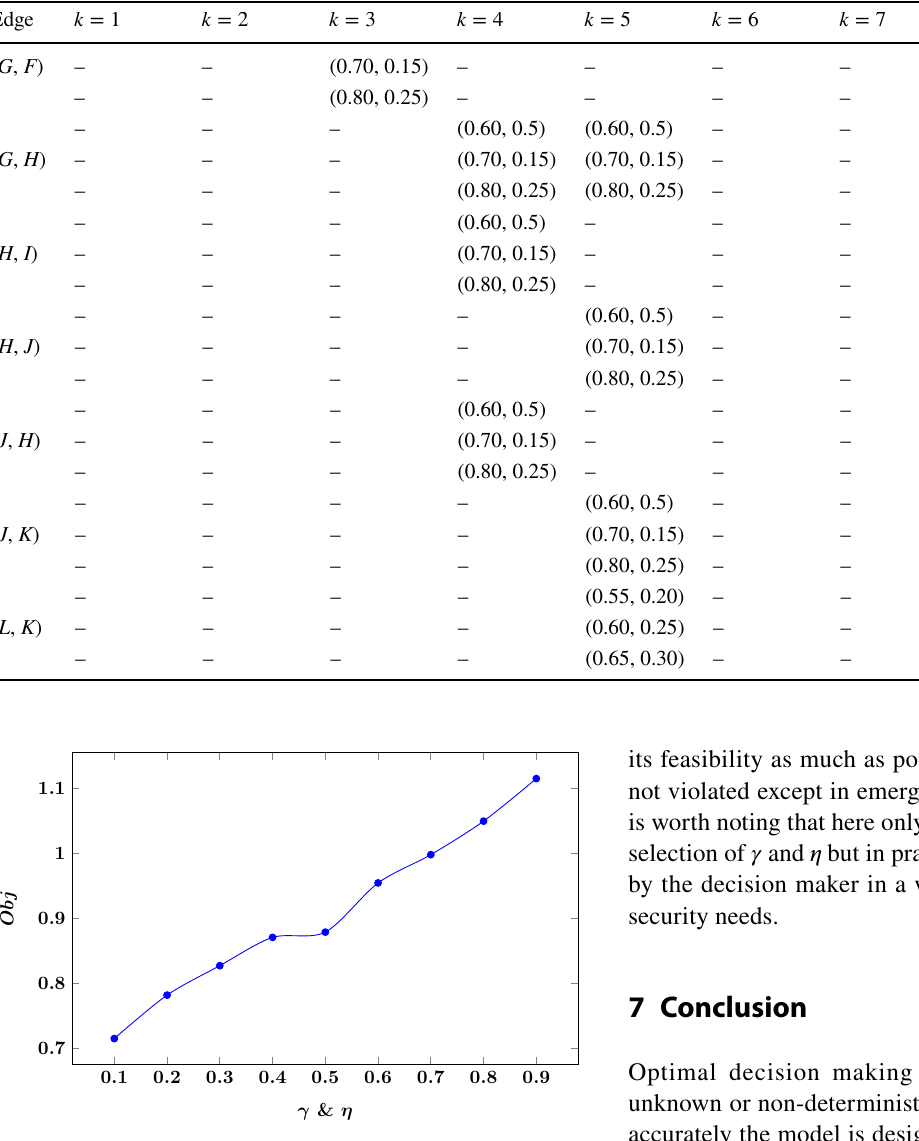
Fig. 4 The optimal value of the objective function for different values 𝛾 and